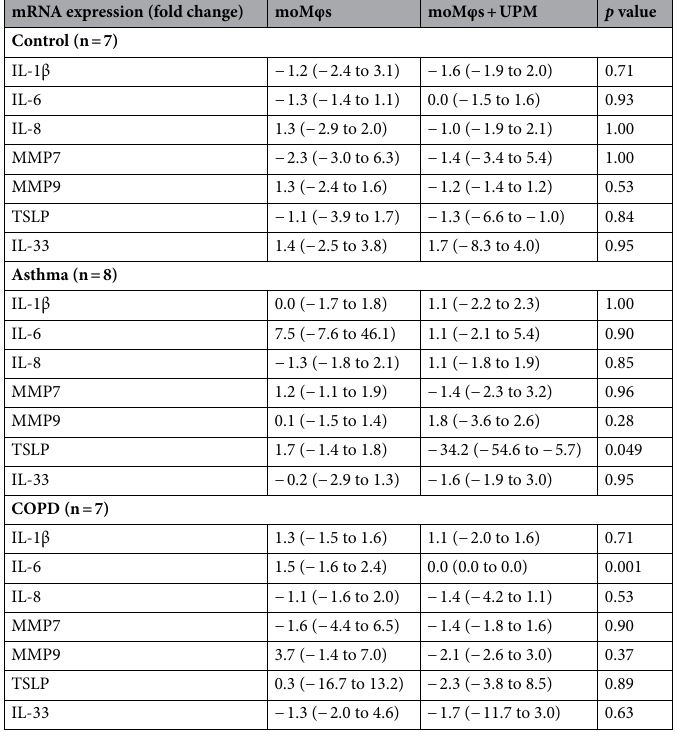
Table 3. mRNA expression of IL-1β, IL-6, IL-8, MMP7, MMP9, IL-33 and TSLP in moMφs of control, asthma and COPD patients with and without UPM treatment. The results are presented as median and IQR.